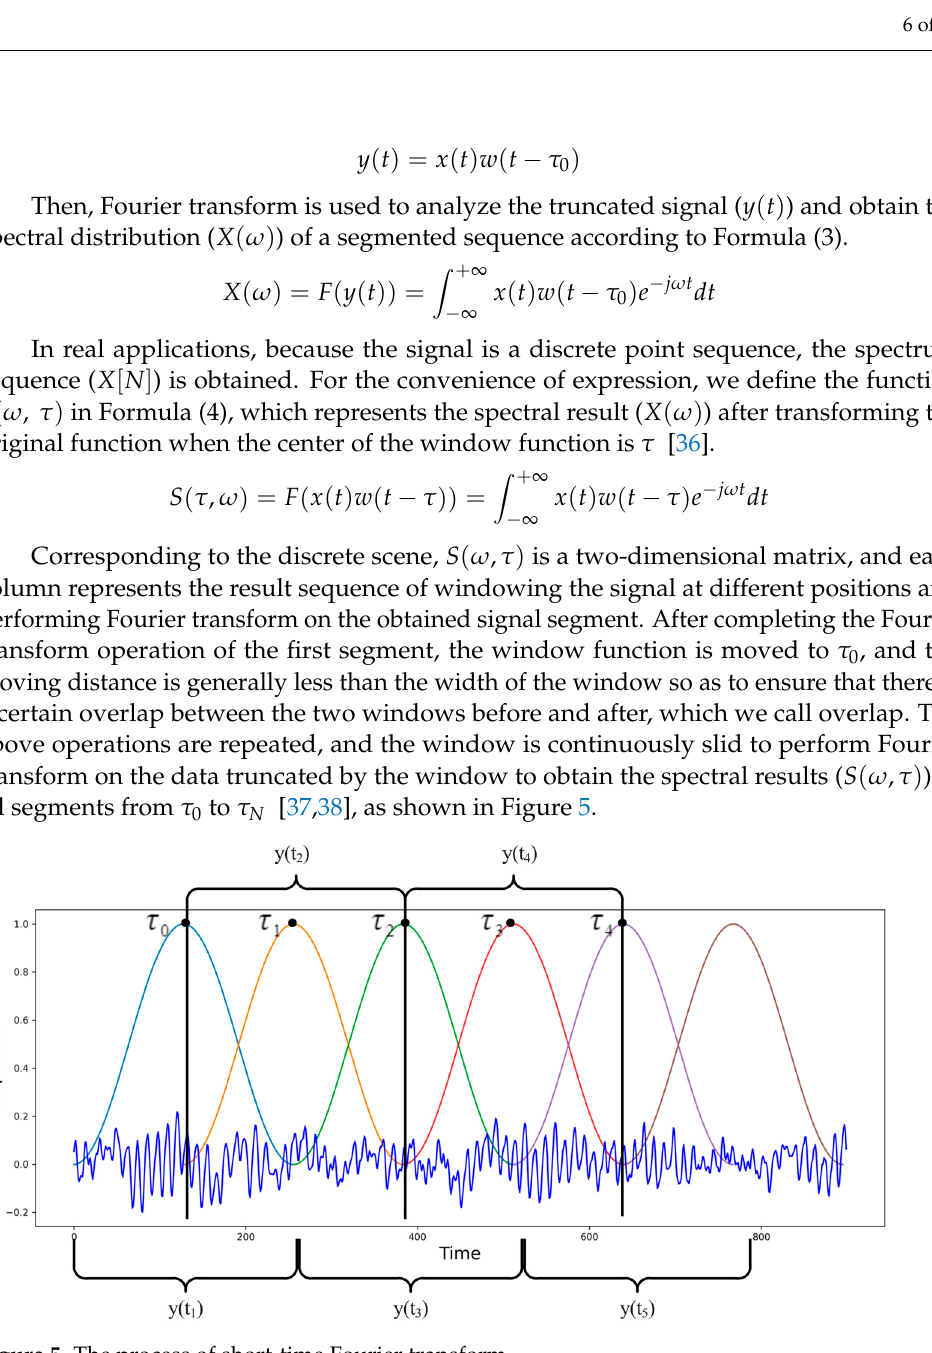
Figure 5. The process of short-time Fourier